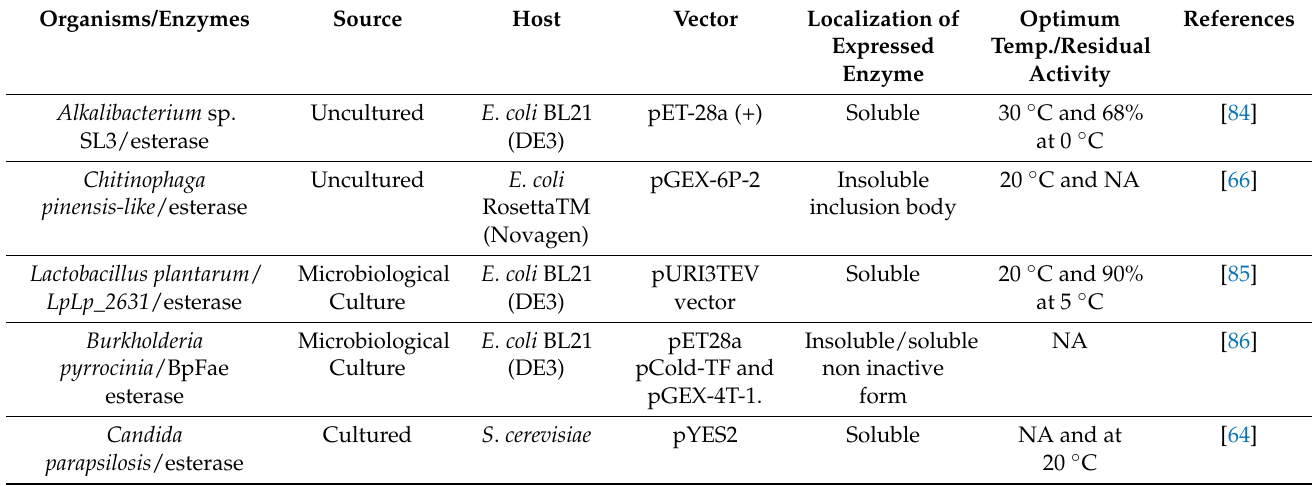
Table 1. Cold Active Lipase and Esterase Overexpressed in Heterologous